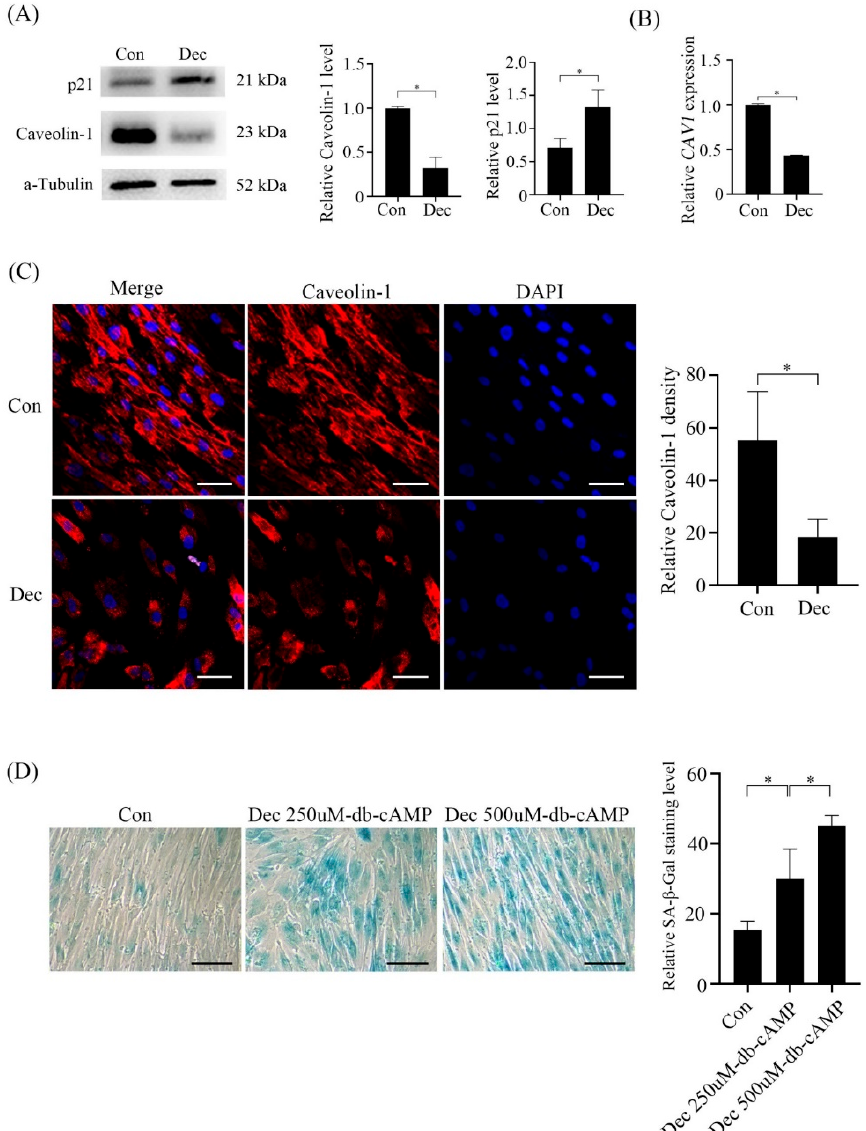
Figure 7. Caveolin-1 levels and SA- β -Gal staining in human stromal cells under in vitro decidualization. ( A ) Western blot analysis of Caveolin-1 and p21 protein levels in stromal cells under in vitro decidualization for 6 days. ( B ) Real-time PCR analysis of Caveolin-1 mRNA expression in stromal cells under in vitro decidualization for 4 days. ( C ) Caveolin-1 immunofluorescence and semi-quantitative analysis in stromal cells under in vitro decidualization for 6 days. ( D ) SA- β -Gal staining and semi-quantitative analysis in stromal cells under in vitro decidualization for 6 days with different doses of db-cAMP. Scale bar = 20 μ m. *, p < 0.05.